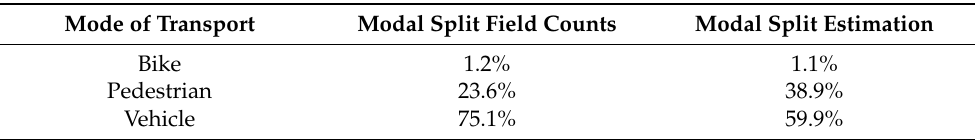
Figure 14. Testing area in the district of Supilinn and the locations of manual counts. Table 2. Modal split for the manual counts and the estimated counts for the district of Supilinn on 10 December 2021, from 8:00 to